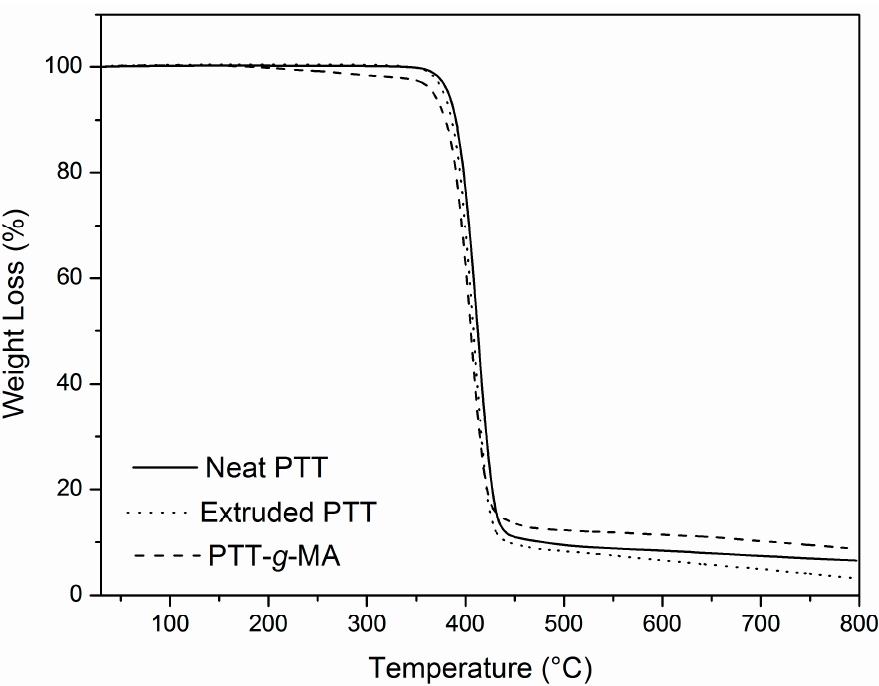
Figure 5. Thermal degradation behavior of neat PTT, extruded PTT, and PTT- g -MA. Table 2. Initial thermal degradation temperature (T onset ), temperatures at weight loss of 10% and50%, and maximum weight loss rate temperature (T max ).